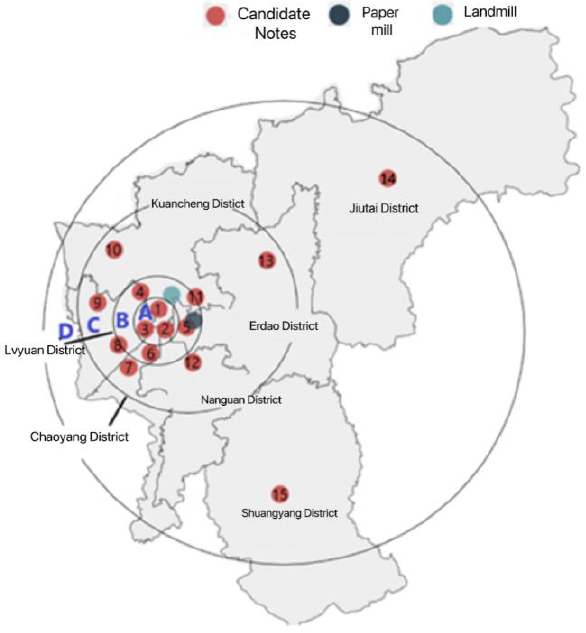
Figure 12. Schematic diagram of candidate node sub-region location.